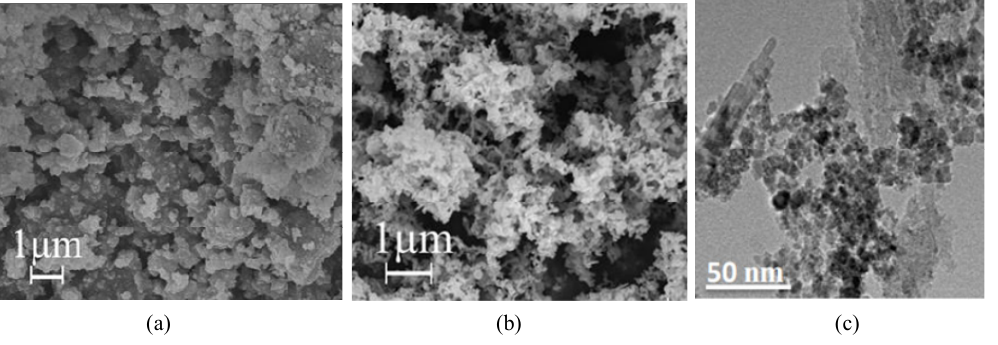
Figure 2. Diffraction results of three BC composites (( a ): SEM characterization result of ZVI; ( b ): SEM characterization result of BC Composites; ( c ): TEM representation results of BC composites).